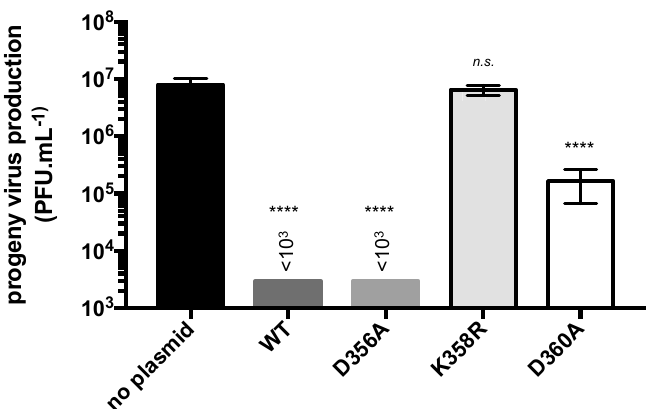
Figure 5. Antiviral activity of rVP mutants against ZIKV. A549 cells were transfected at 18 h with plasmids expressing rVP wt (WT), rVP-D356A (D356A), rVP-K358R (K358R), or rVP-D360A (D360A) or mock-transfected (no plasmid). Cells were infected at 24 h with ZIKV strain BR15 at MOI of 1. Virus